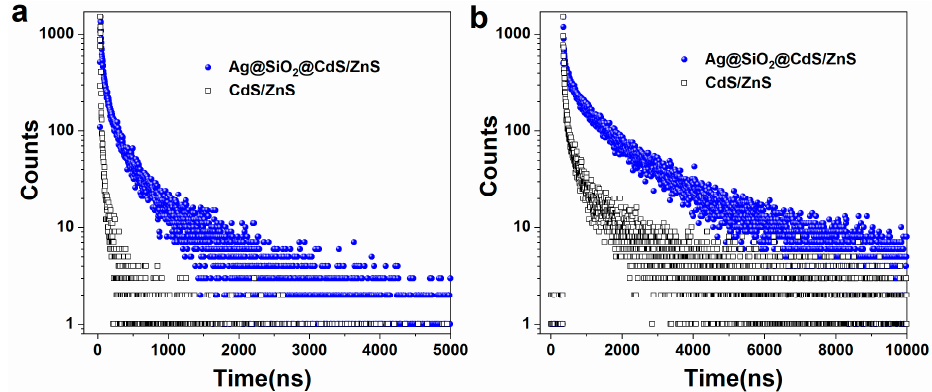
Figure 5. The time-resolved intrinsic fluorescence intensity ( a ) and defect fluorescence intensity ( b ) of CdS/ZnS QD (black open square) and Ag@SiO 2 (12 nm)@CdS/ZnS QD composite nanoparticles (blue sphere).